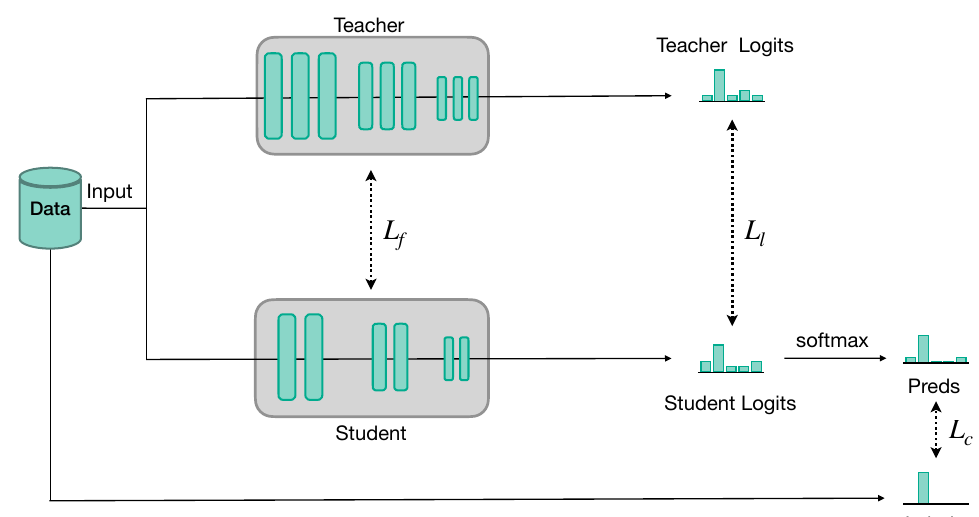
Figure 8. Illustration of the knowledge distillation process. Besides learning the labels from data, the student is also given some cues from the teacher, either from intermediate features, or from the teacher’s